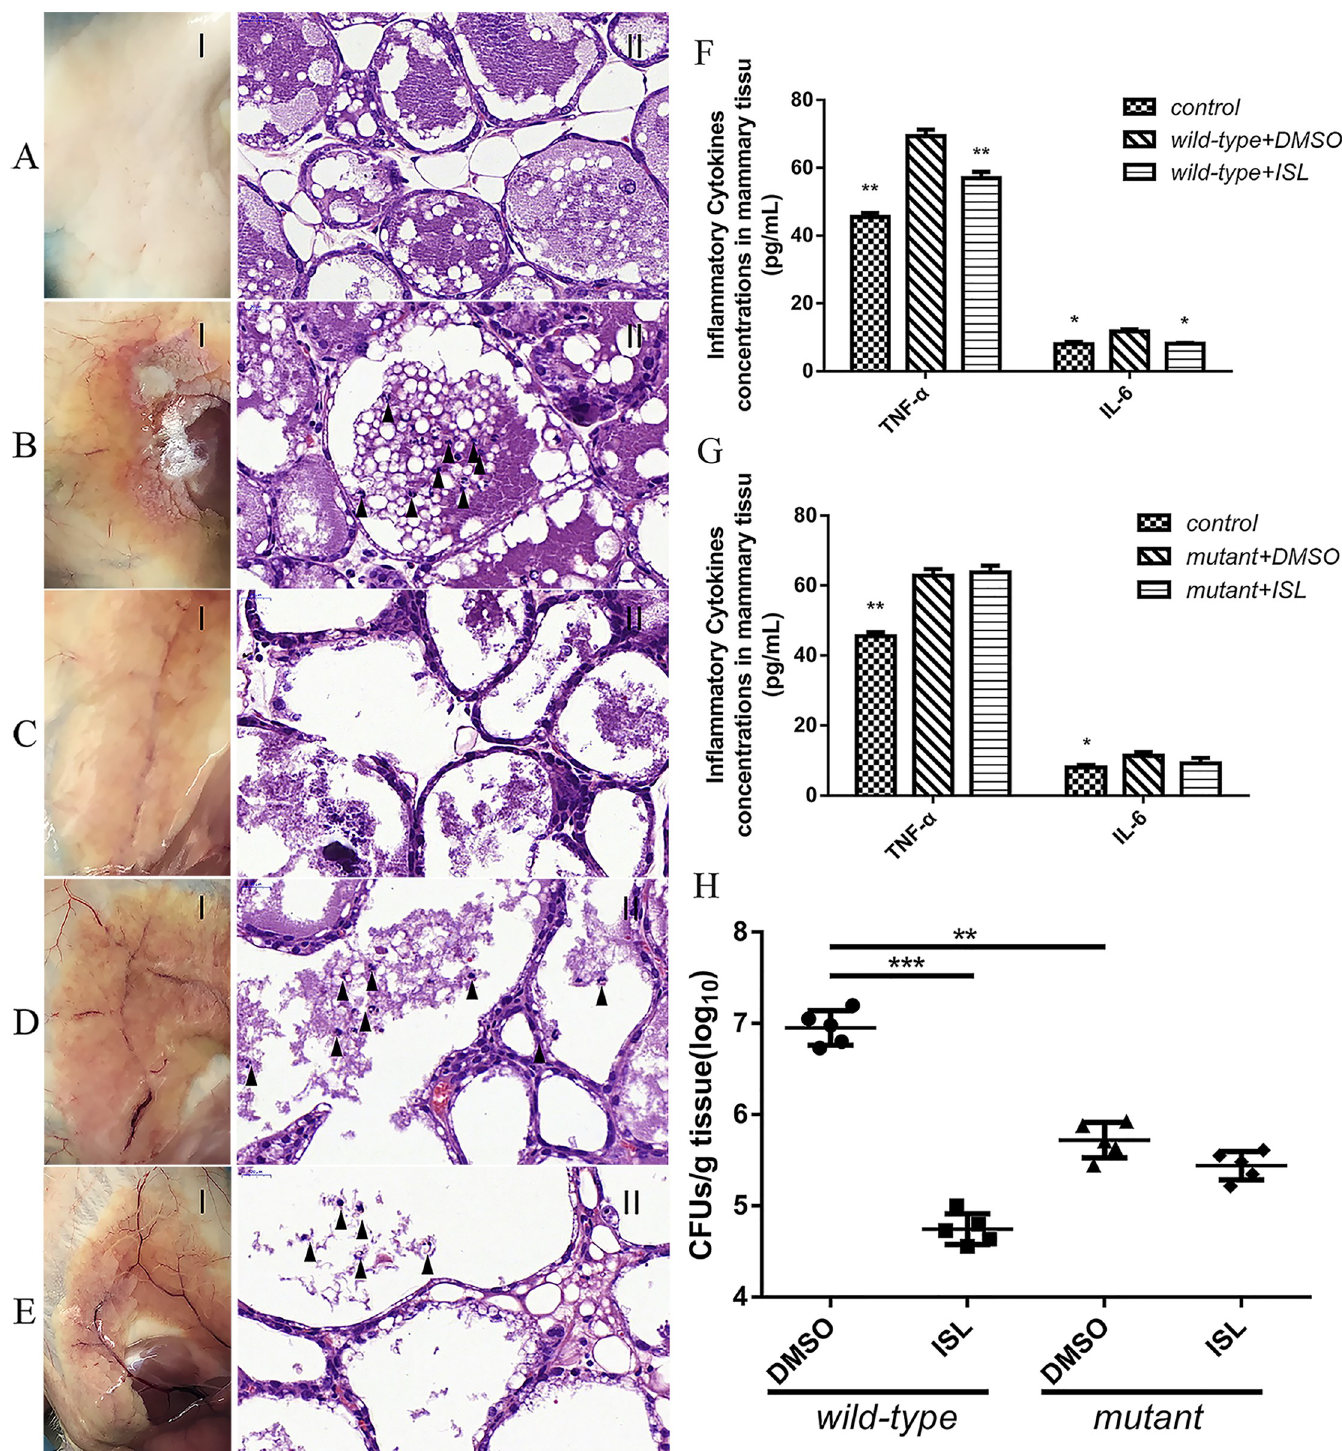
Fig 8. ISL provides protection against S . xylosus mastitis in a mouse model. Lactating BALB/c mice were infected by injecting the canal glands with 1 × 10 9 CFU bacterial cells. (A-E) The gross pathological changes (I) and histopathological analysis (II) of the mammary gland tissues at 48 h post-infection (n = 5) (Magnification: 600 × ). The infection group showed a large number of inflammatory factors and breast tissue destruction (arrowheads). Pathological abnormalities were significantly reduced by 250 μ g/kg ISL in infected mice compared with DMSO treated mice. (F, G) ISL reduces the inflammatory response in infected mice. The levels of cytokines, including IL-6, and TNF- α , in the mammary gland tissues of infected mice were evaluated by ELISA (n = 5) ( � p < 0.05, �� p < 0.01, and ��� p < 0.001). (H) The effect